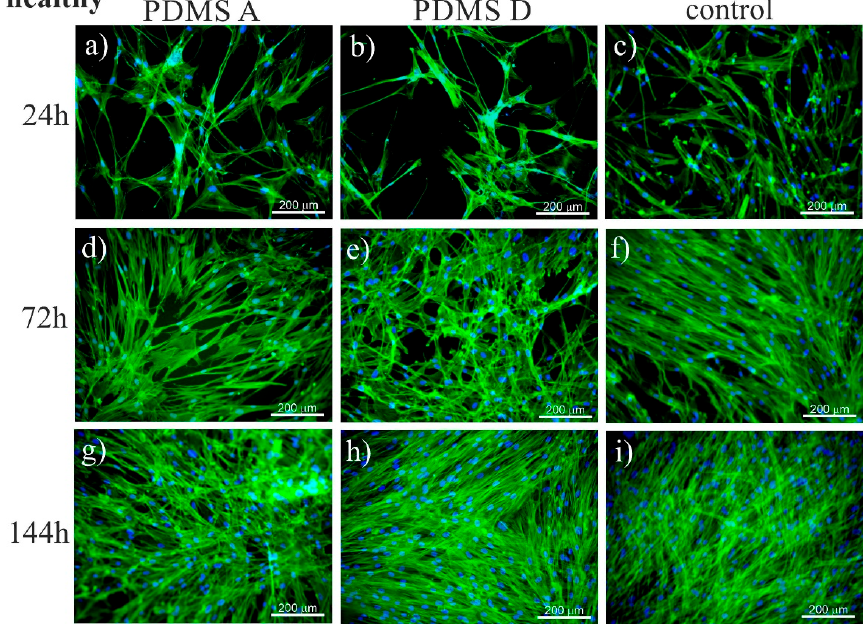
Figure 1. Fluorescence micrographs of the actin cytoskeleton (green) and nuclei (blue), recorded for healthy fibroblasts cultured for 24 ( a – c ), 72 ( d – f ), and 144 h ( g – i ) on PDMS A ( a , d , g ), PDMS D ( b , e , h ), and control samples (glass, ( c , f , i )).